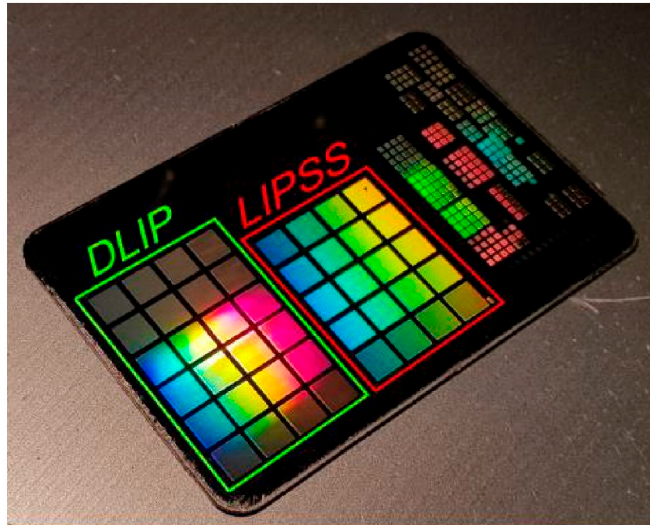
Figure 7. Photograph of structural colors generated on a polished steel plate by DLIP and LIPSS processing, as indicated on the sample. Reproduced from Soldera et al. [50], with permission from Japan Laser Processing Society.